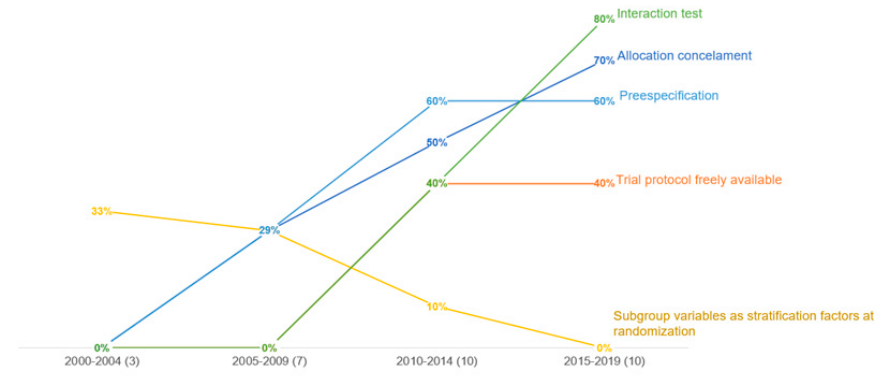
Figure 2. Evolution of subgroup analysis